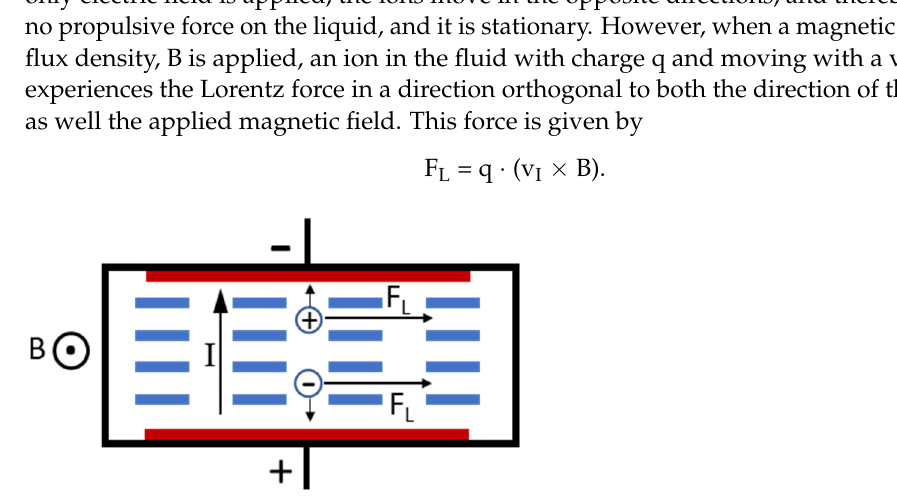
Figure 1. Operating principle of a typical ionic fluid magnetohydrodynamic (MHD) pump. The cations and anions are both propelled in the same direction by the Lorentz force.